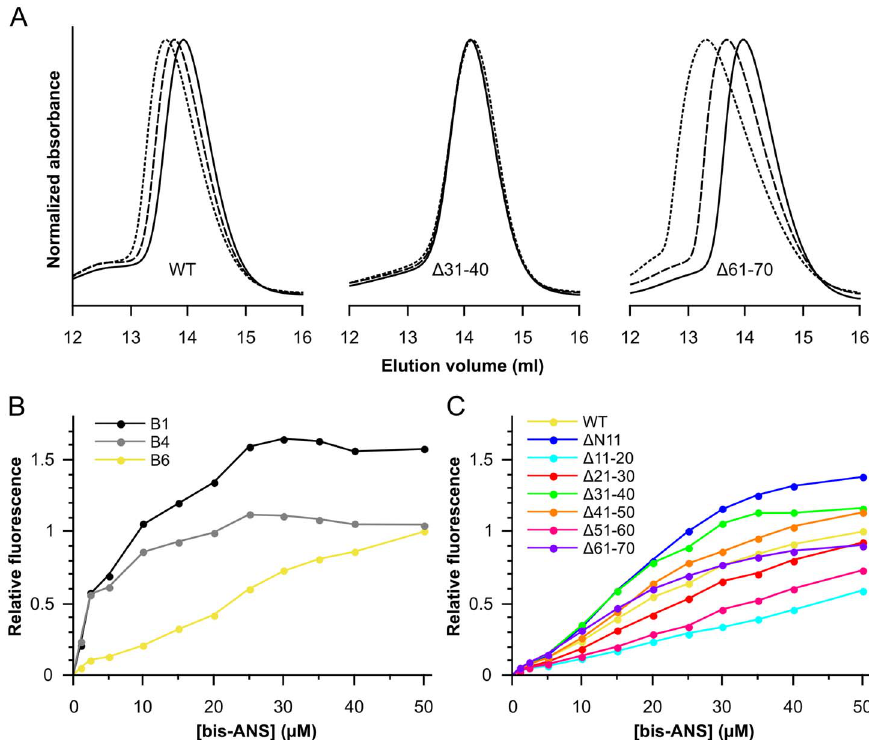
Figure 4. Solution properties of the HSPB6 10-residue deletion mutants. (A) Size-exclusion chromatography profiles of wild-type HSPB6, D 31–40 and D 61–70. 100 m l of protein at three different concentrations was loaded on a Superdex 200 10/300 GL column. 2.5 mg/ml is depicted as a solid line, 5 mg/ml as a dashed line and 10 mg/ml as a dotted line. The absorbance was normalized to the maximum absorbance for each curve. (B) Bis-ANS titration curves for HSPB1, HSPB6 and HSPB4. 2.5 m M protein was mixed with increasing concentrations of bis-ANS and fluorescence intensity was recorded at 490 nm using an excitation wavelength of 390 nm. HSPB6 is shown in yellow, HSPB1 in black and HSPB4 in grey. (C) Bis-ANS titration curves for all constructs, the same setup as for HSPB1 and HSPB4 was used. HSPB6 is shown in yellow, D N11 in blue, D 11–20 in cyan, D 21–30 in red,